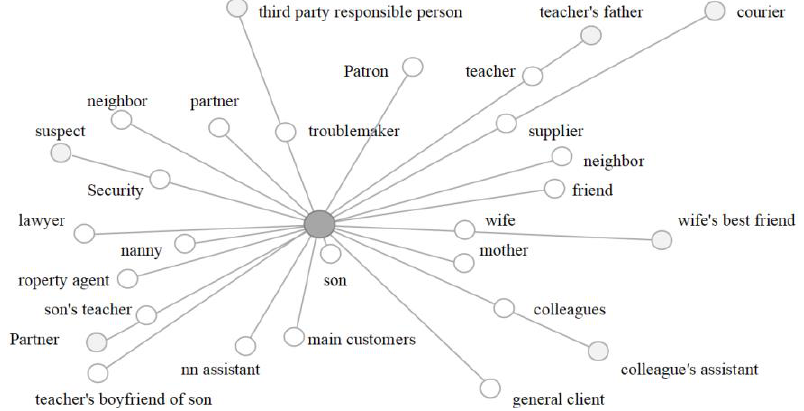
Fig. 1. A social ecosystem with a user as the center and composed of all stakeholders. Here, the dark gray circle represents a user, the light gray circle represents the stakeholders with direct relationship, the white circle represents the stakeholders with indirect relationship, and each arrow line represents the geographic location and distance between the user and the